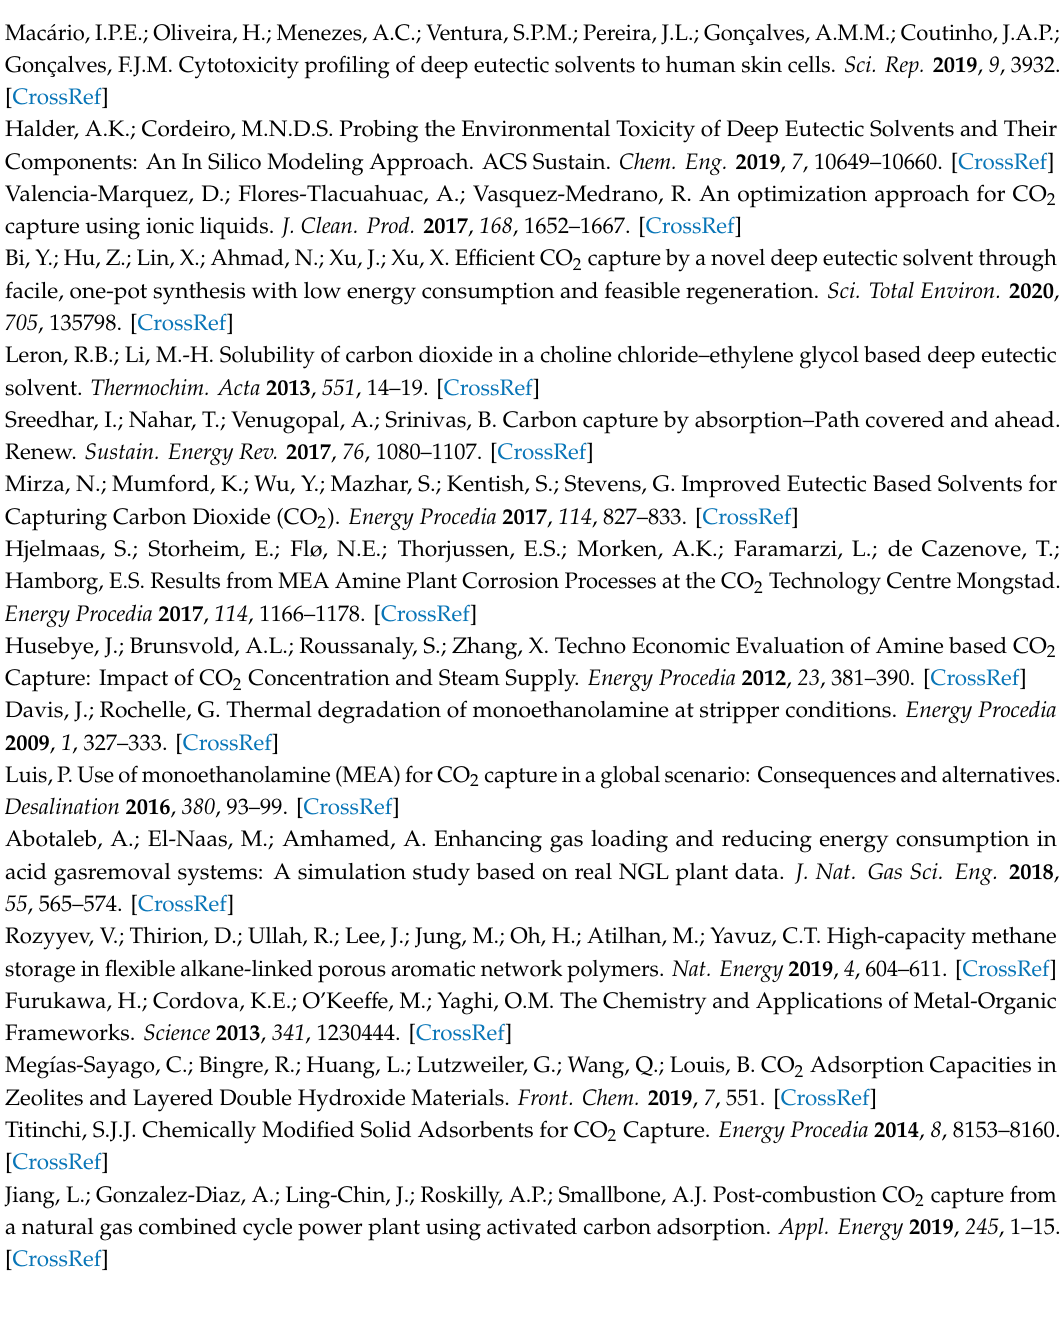
Figure S1: title. CO 2 capture performance for hydrogen bond acceptors and hydrogen bond donors prior to mixing to form deep eutectic solvent at 298.15 K isotherm with (mol CO 2 / mol solvent